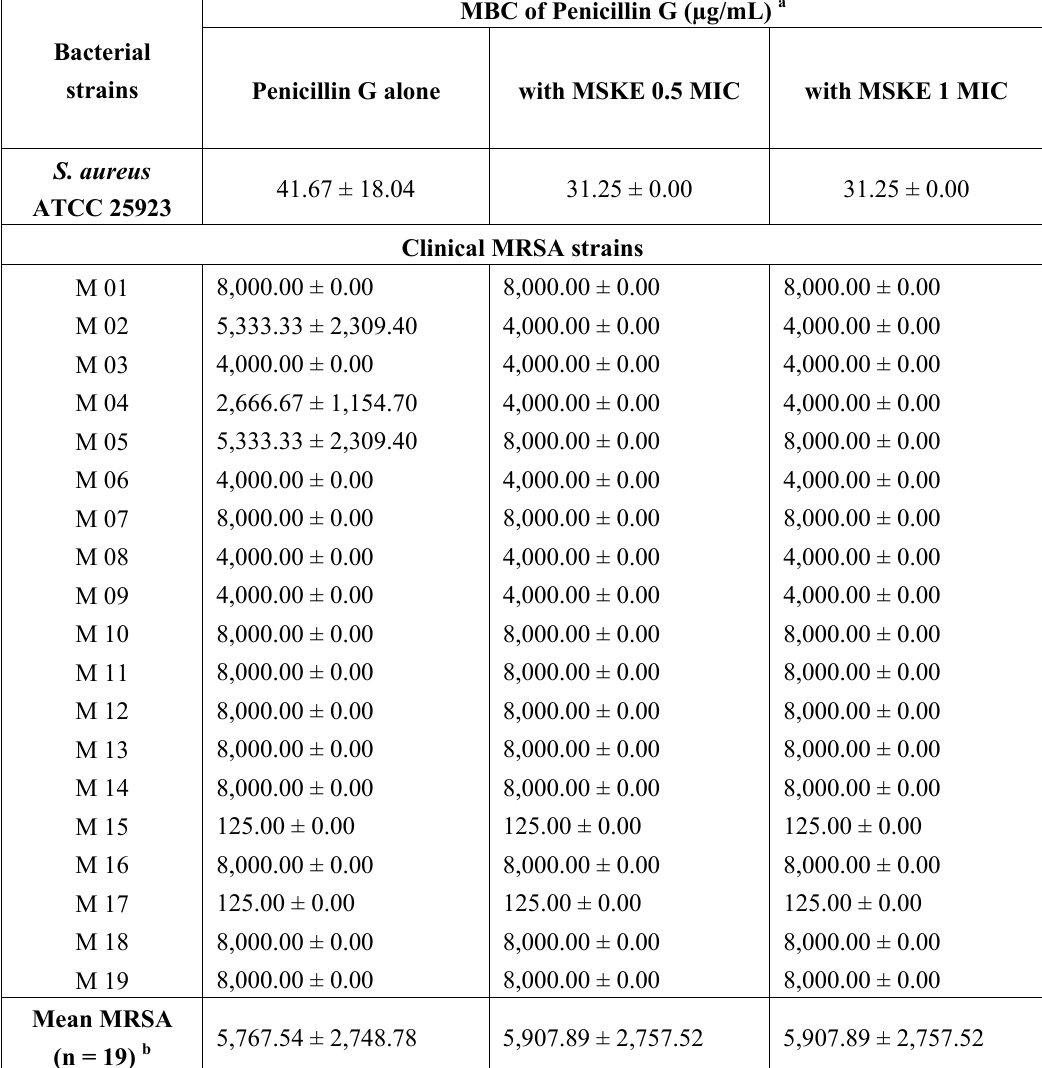
Table 4. Effects of MSKE and its phenolic principles on the MBCs of penicillin G against S. aureus ATCC 25923 and clinical MRSA strains ( a mean values ± S.D. of triplicate results, b mean values ± S.D. from 19 MRSA